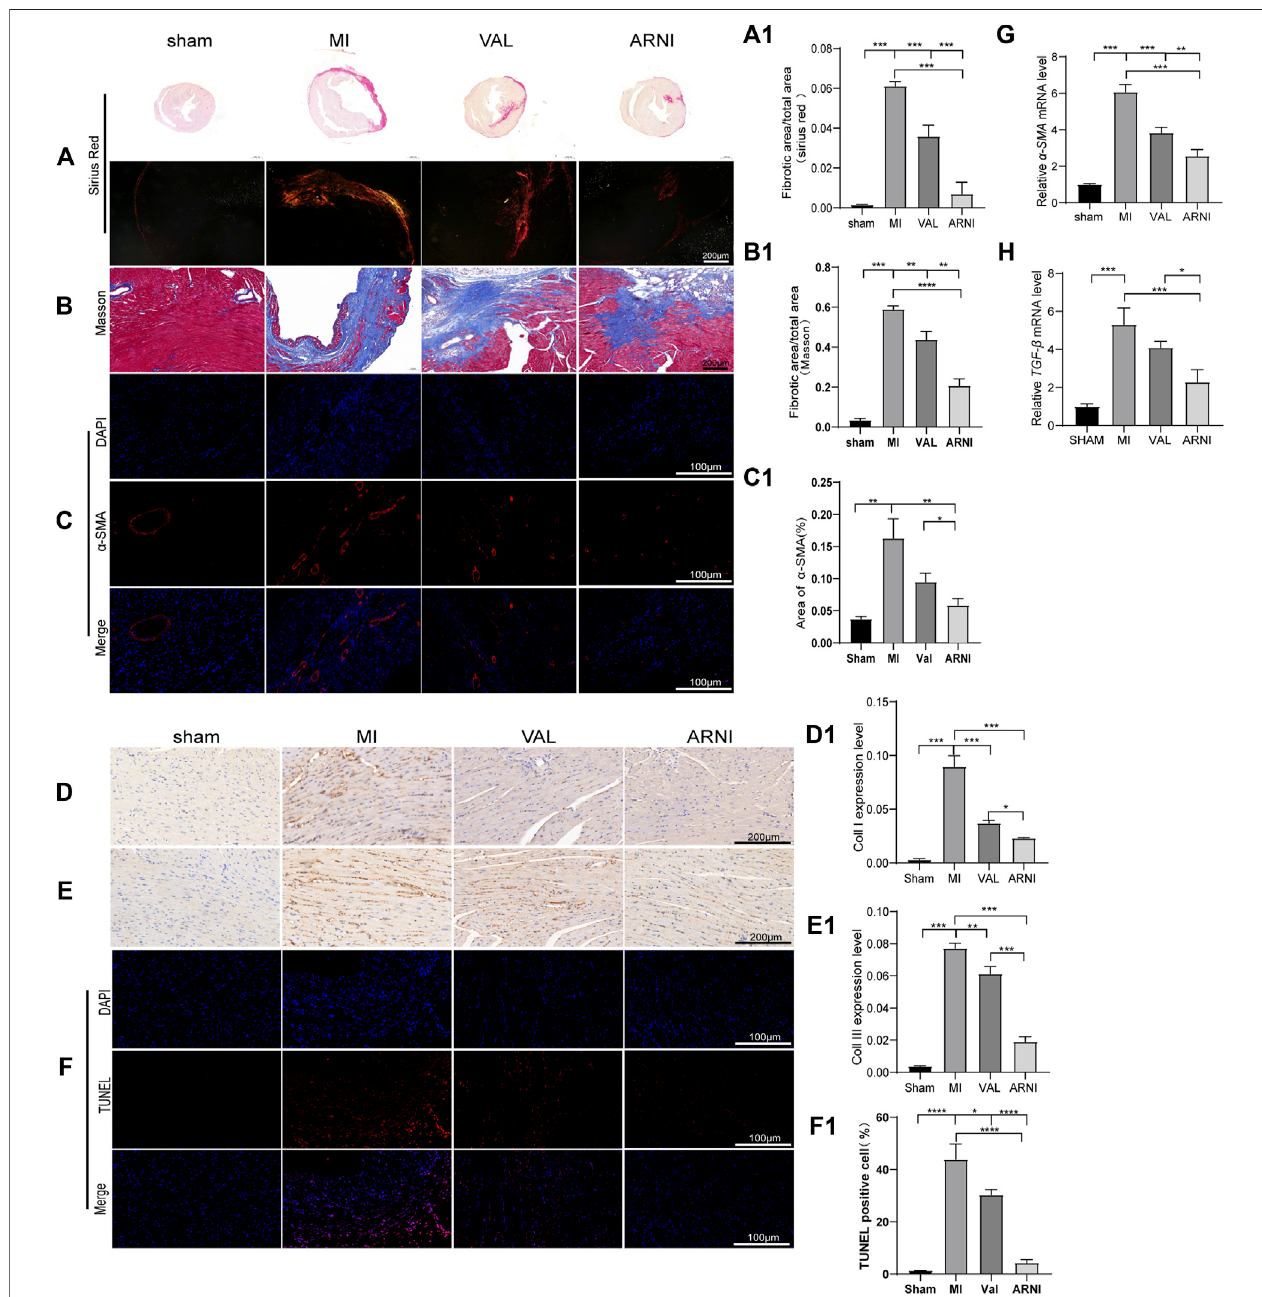
FIGURE 3 | Effects of ARNI on myocardial fi brosis in mice with MI. (A) Sirius Red staining of myocardium tissues (2nd row, scale bar (cid:1) 100 μ m). (A1) Quantitative analysisofmyocardial fi brosis(SiriusRedstaining). (B) Masson ’ strichromestainingofmyocardiumtissues(scalebar (cid:1) 200 μ m). (B1) Quantitativeanalysisofmyocardial fi brosis (Masson ’ s trichrome staining). (C) Immuno fl uorescence images of myo fi broblasts derived from CFs. Red, α -SMA; Blue, nuclei. (scale bars (cid:1) 100 μ m). (C1) Quantitative analysis of α -SMA; (D,D1 , E,E1) Immunostaining of collagen I and collagen III. (F) TUNEL staining of myocardium (scale bar (cid:1) 100 μ m). (F1) . Quantitative analysis of TUNEL positive cells. (G,H) Relative mRNA level of α -SMA and TGF- β .Each group n (cid:1) 7. * p < 0.01,** p < 0.05, *** p < 0.001.